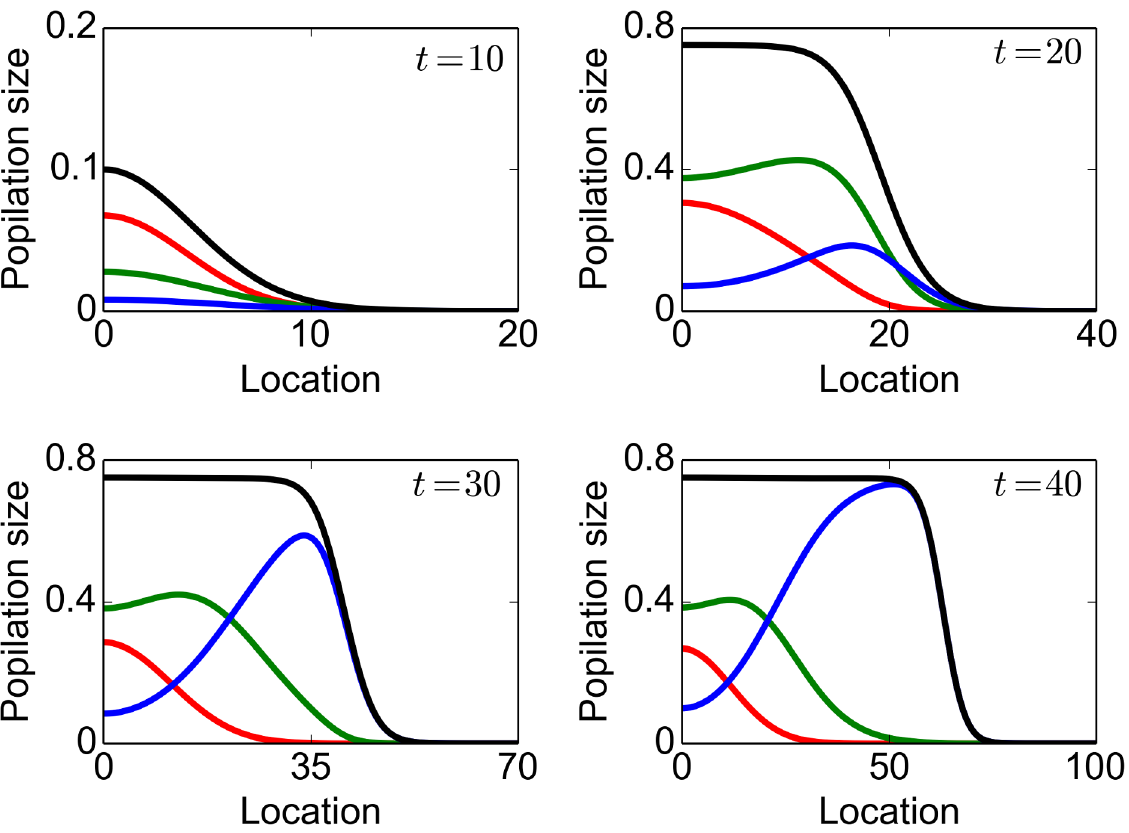
Figure 4. Evolution of the mean dispersal ability and expected dispersal kernels. (A–B) Mean dispersal ability: During the invasion, the dispersal ability at the front is higher than the dispersal ability at the core of the invasion. The region in blue indicates habitats that have not been invaded at each generation. (C–D): The expected dispersal kernel at the core of the invasion (in black) is narrower than that at the front of the invasion (blue). In both cases, the expected dispersal kernel (full circles) can be approximated by the kernel associated to the mean dispersal ability (Eq (8) and Eq (9)) (Solid lines). Figures (A,C) and (B,D) were obtained using Gaussian and Laplace dispersal kernels respectively.